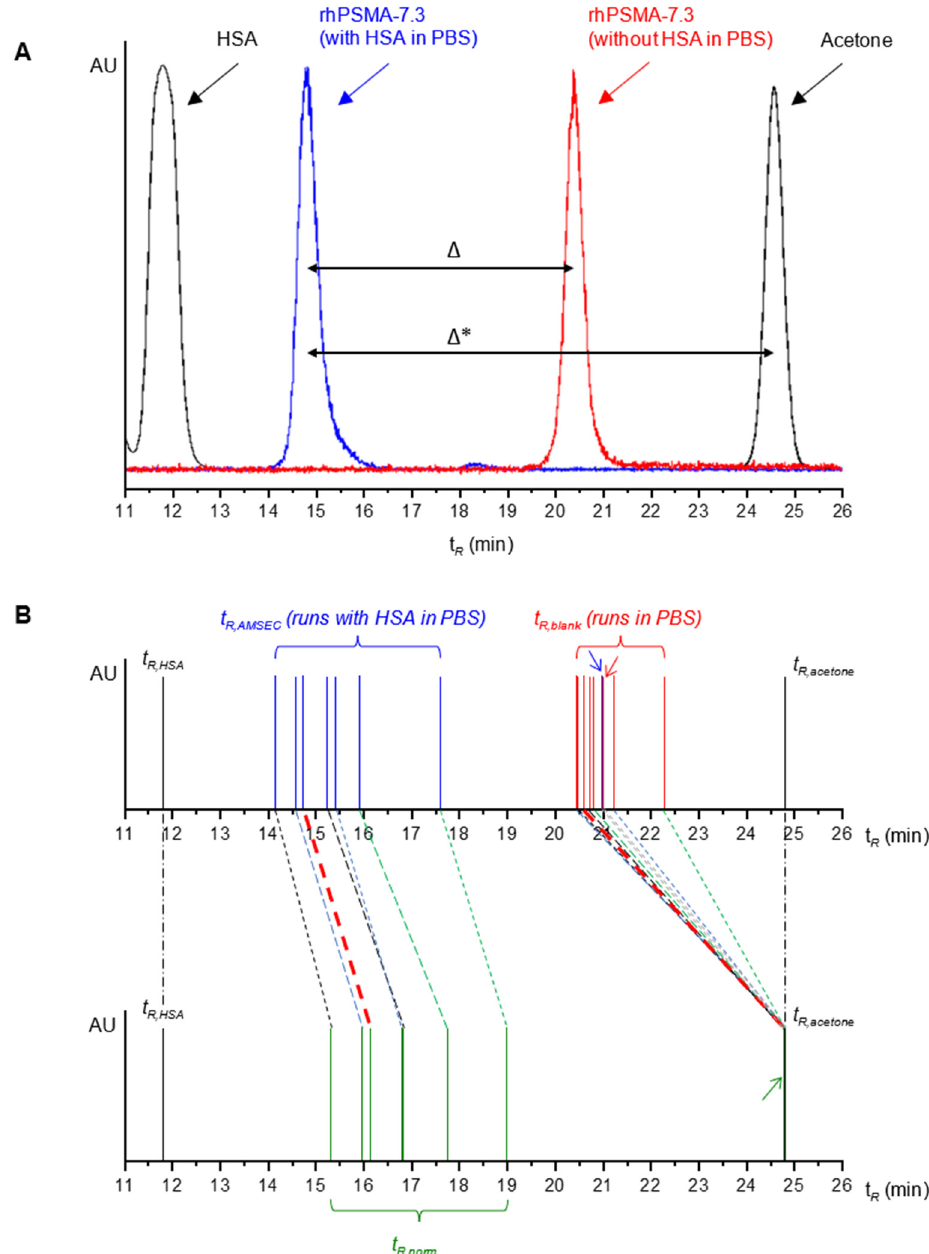
Figure 3. ( A ) The elution profile of the blank run (red) of rhPSMA-7.3 (in PBS without HSA) showed a significantly shorter retention time (t R ) than for acetone, probably due to unspecific electrostatic interactions of the radioligand with the column matrix. The actual albumin-mediated reduction in t R ( Δ ) was, therefore, smaller than initially expected ( Δ *). ( B ) Graphical depiction of normalization of t R,AMSEC that was carried out to correct for unspecific interaction with the column matrix. Within the t R window between HSA (t R,HSA , 100% HSA binding) and acetone (t R,acetone , 0% HSA binding), normalized t R (t R,norm. ) were obtained by the proportional dilatation of t R,AMSEC (ligand-specific HSA binding) and t R,blank (0% HSA binding) to the extent that all t R,blank values became equal to t R,acetone . For the purpose of better readability, the blue, red, and green arrows indicate the t R,AMSEC , t R,blank , and t R,norm. of PSMA-I&T, respectively.